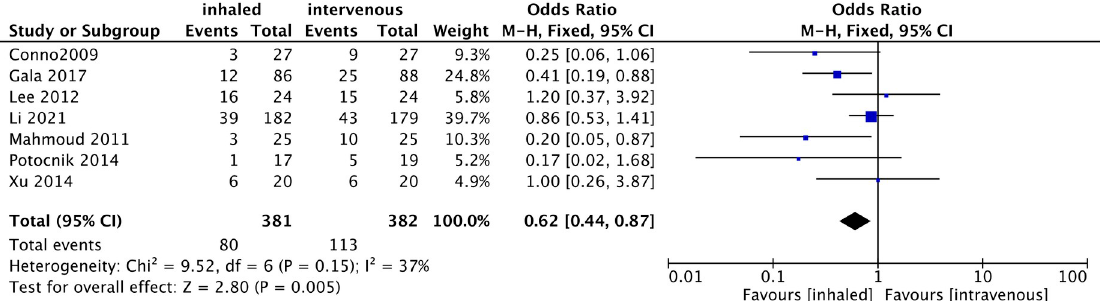
Fig 4. Forest plot for the number of postoperative pulmonary complications between inhaled and propofol groups.